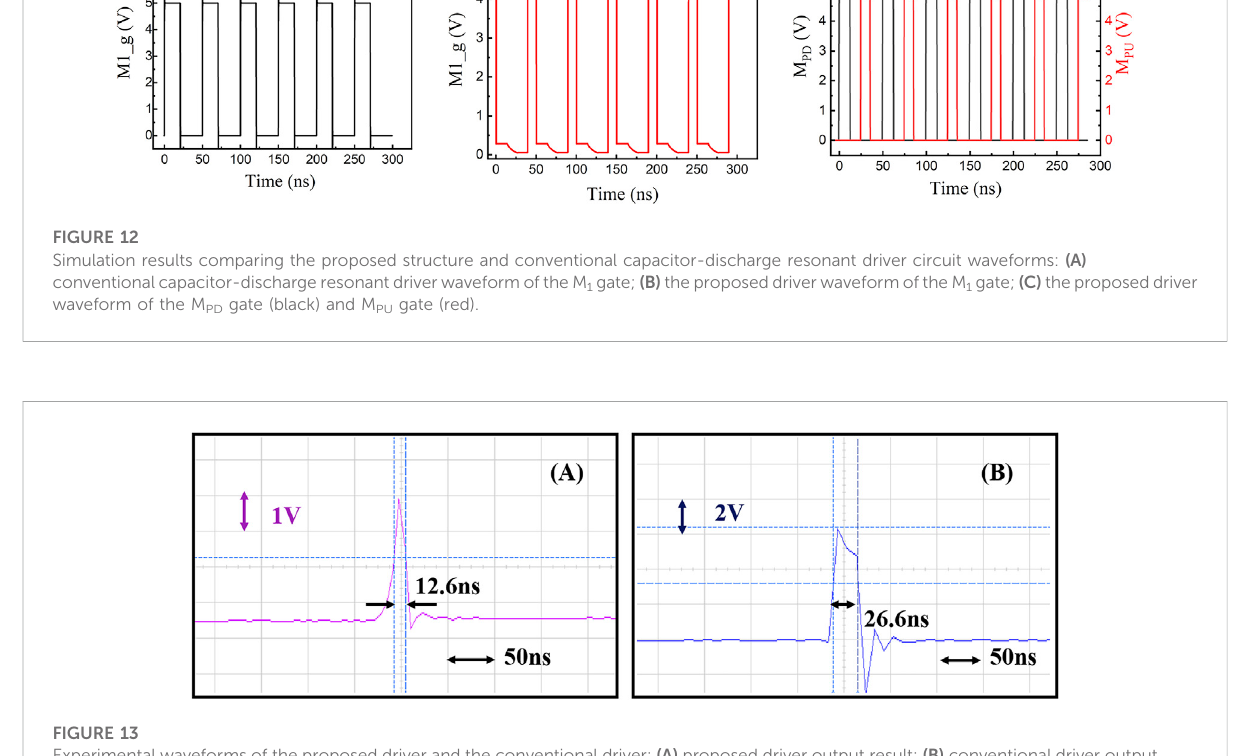
Experimental waveforms of the proposed driver and the conventional driver: (A) proposed driver output result; (B) conventional driver output